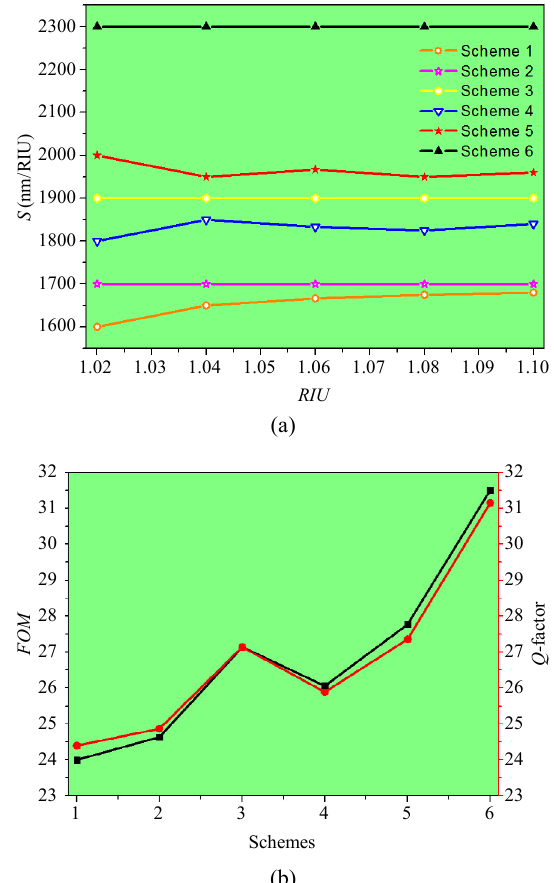
Fig. 5 Sensor performance: (a) S and (b) FOM and Q- factor of design Schemes 1 –